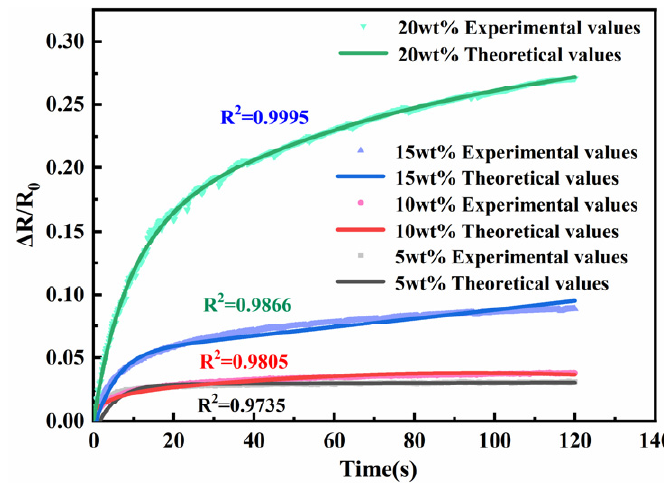
Figure 7. Diagram of graphene mass fraction vs. sensing unit resistance to creep.